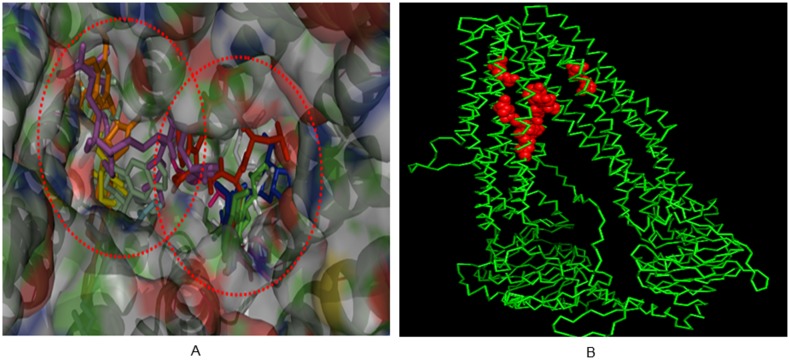
Docking of ten reference compounds revealed the presence of two substrate binding sites in the ABCC6 open conformation model.A) Intracellular view of the docked reference molecules showed that all the molecules are clustered in two substrate binding sites (SBS) of the ABCC6 homology model (indicated by two red dotted circles). In addition, intersections of the reference molecule in the binding sites revealed the overlap and flexibility of the binding sites. B) Location of SBS in the ABCC6 open conformation structure represented in PyMOL. The 3D structure of ABCC6 is green and the major amino acids involved in SBS are highlighted in red.